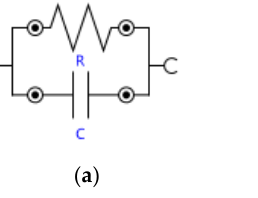
Figure 8. Equivalent circuit models used in this study: ( a ) impedance spectra of undoped membranes and ( b ) impedance spectra of doped membranes. In some cases, either a series inductor or Warburg impedance was included in the model to account for high-frequency inductance or diffusion artifact in the data.